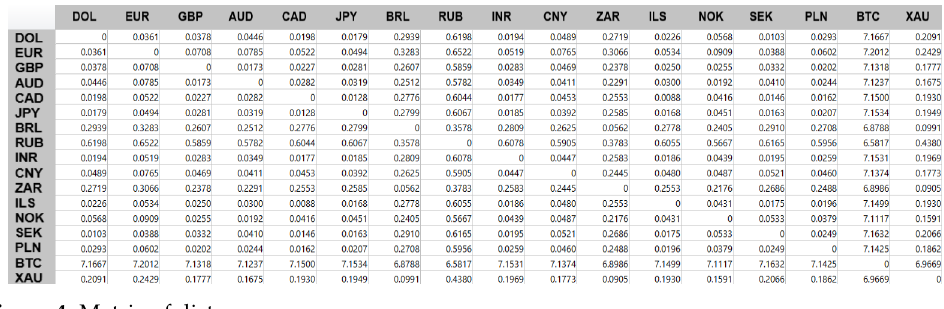
Figure 4. Matrix of distances.